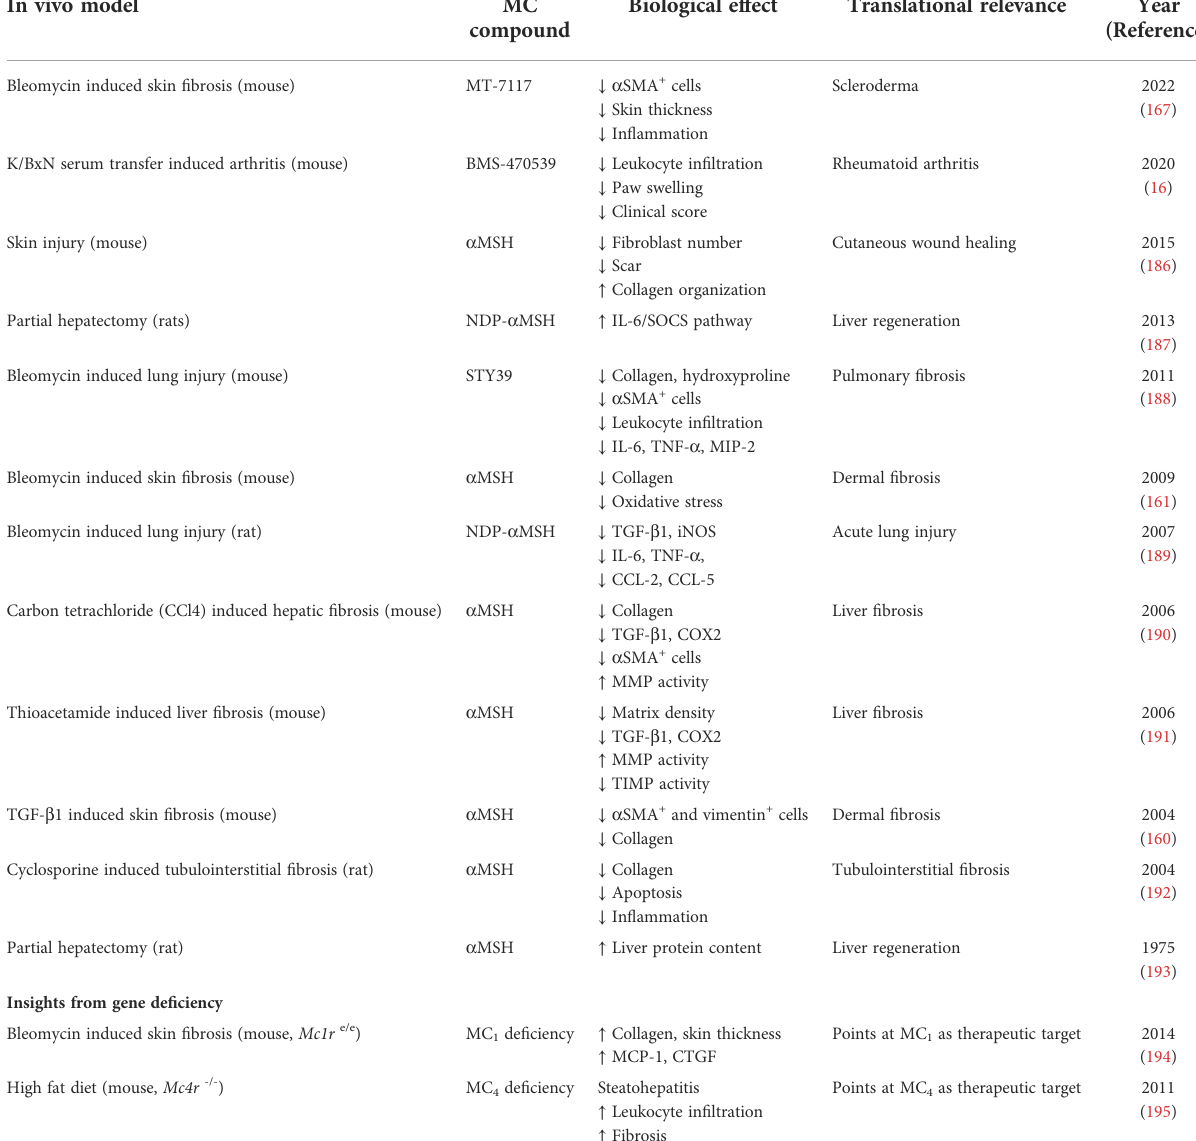
TABLE 2 Testing of melanocortin drugs using in vivo models driven by fi broblasts. In vivo